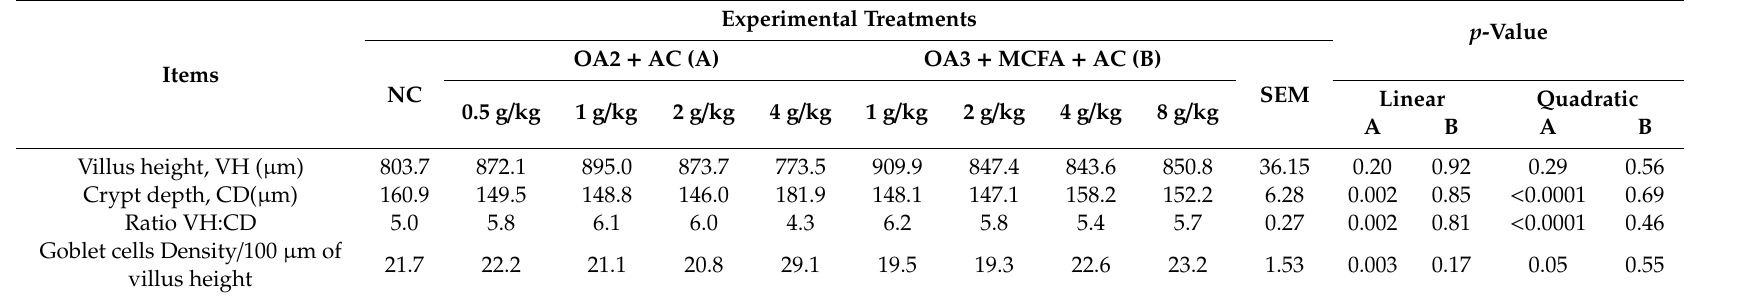
Table 5. E ff ect of dietary treatments on histology of the ileum at the end of the experiment (Trial